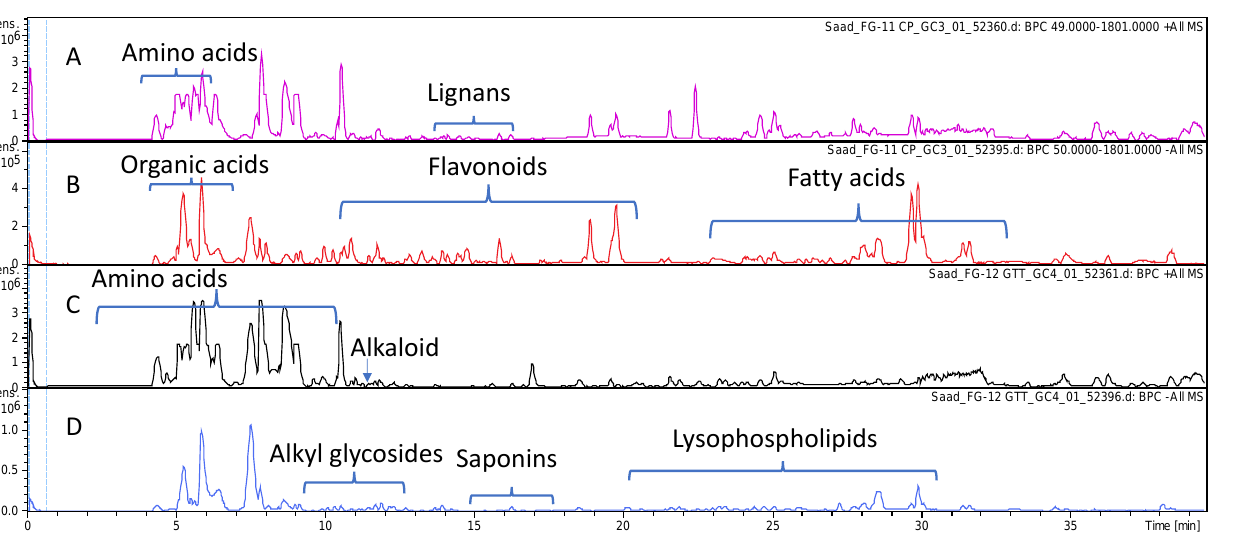
with orange and green colors for bottle gourd and cucumber, respectively. All nodes were labelled with parent mass and edges were labelled with neutral loss